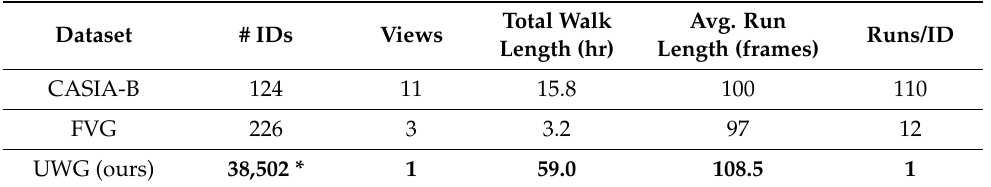
Table 2. Comparison of gait datasets. UWG differs in purpuse, as it is intended for pretraining, and not for evaluation. It is a large-scale dataset, noisily annotated, agnostic to confounding factors and camera viewpoints. * Approximate number given by pose tracker.